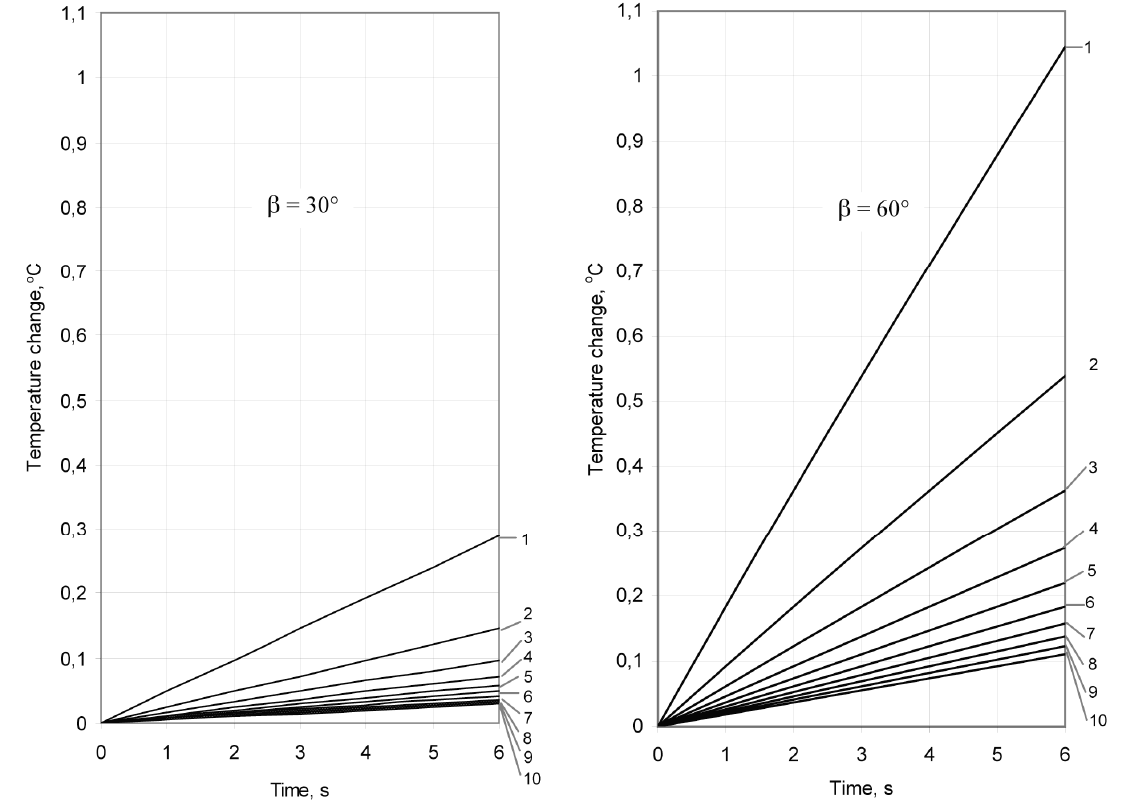
o o and β = 60 , and plant leaf thicknesses of: